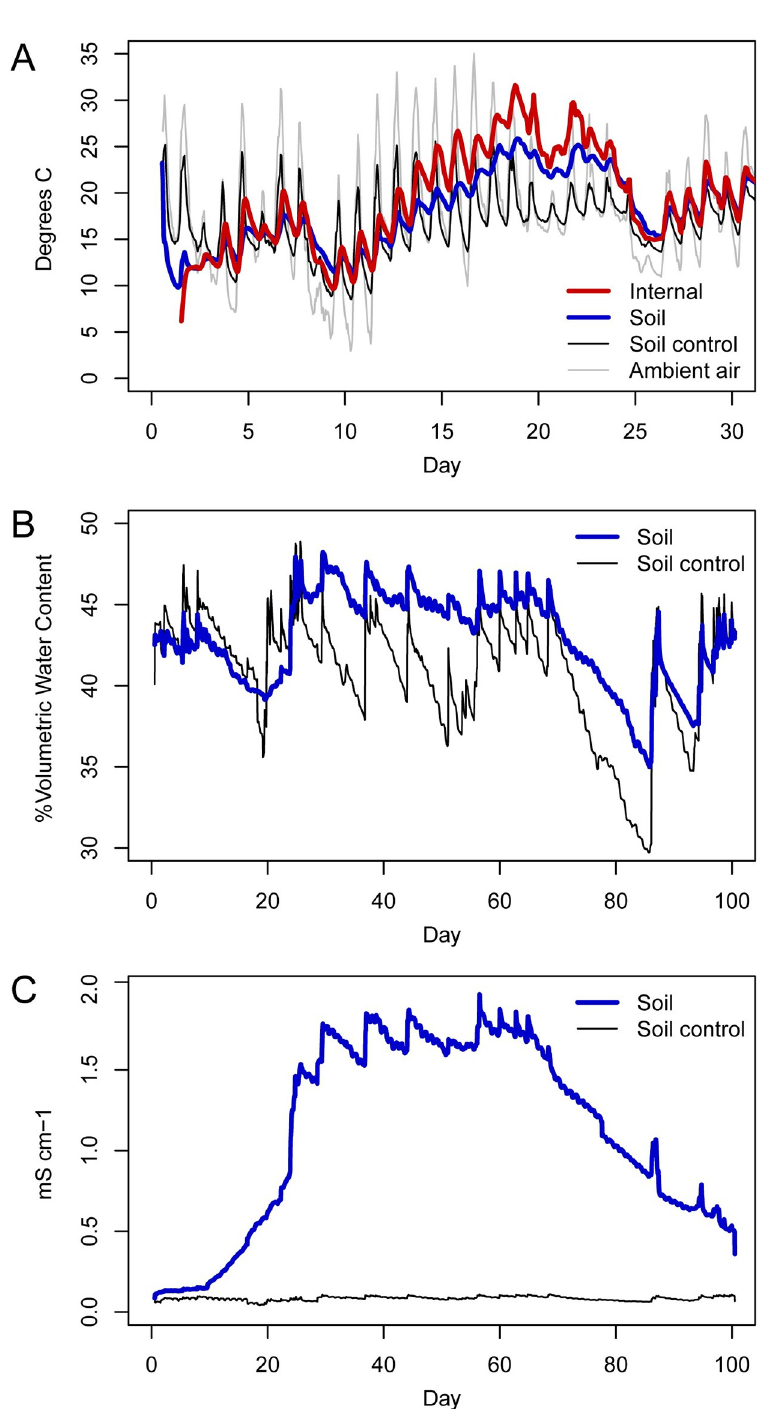
Fig 1. Soil and ambient environmental sensor data. (A) Mean internal, ambient, and soil temperatures, (B), mean soil moisture, and (C) mean soil electrical conductivity. Internal carcass temperature increased beginning on day 13 and remained elevated until day 25. Soil moisture and electrical conductivity rapidly increased following day 21 and remained elevated until day 95. Decomposition-impacted soils are shown in blue (A-C), soil controls are shown in black (A-C), internal temperatures are shown in red (A), and ambient air temperatures are shown in gray (A).